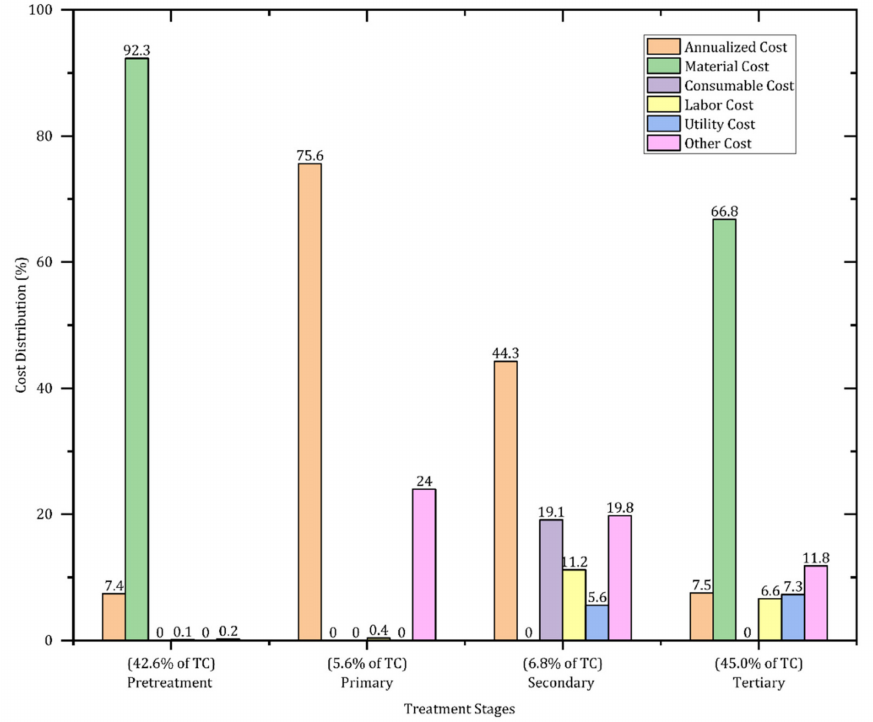
Figure 5. Percentage stage-wise cost for municipal WWT. TC is the total treatment cost. It can be noted that the material cost contributes the highest cost to the total treatment cost. Therefore, other alternatives can be used to lower the cost contribution of the